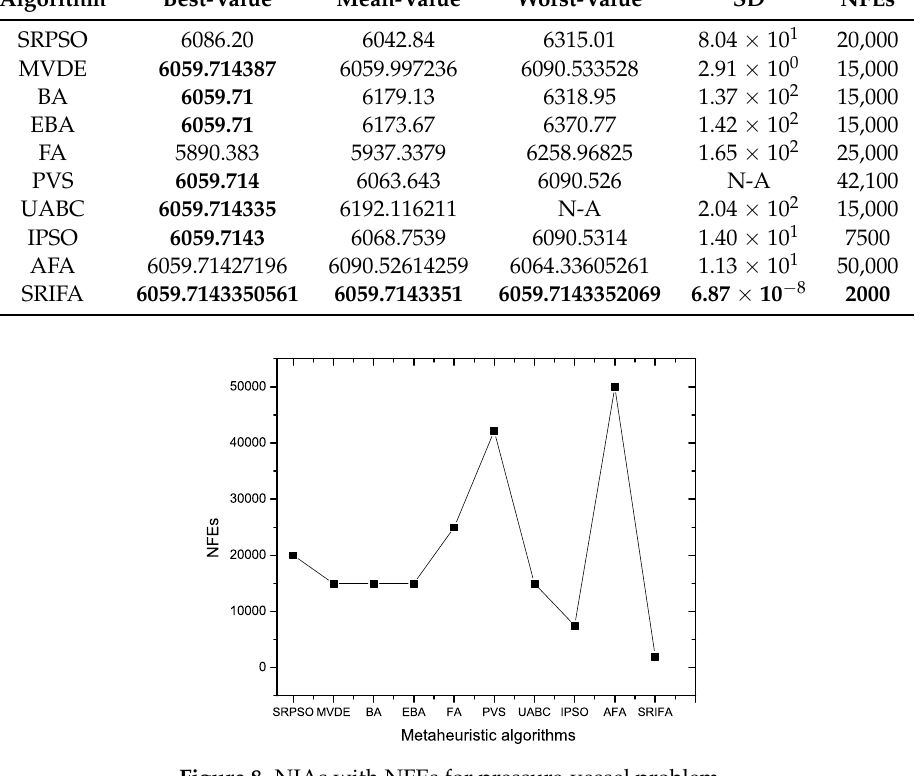
Figure 8. NIAs with NFEs for pressure-vessel